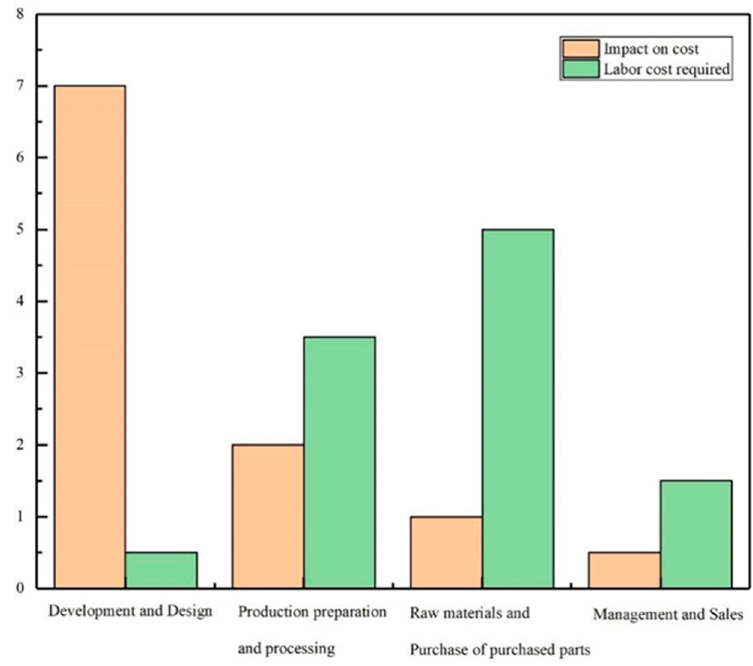
Figure 9. Cost impact.